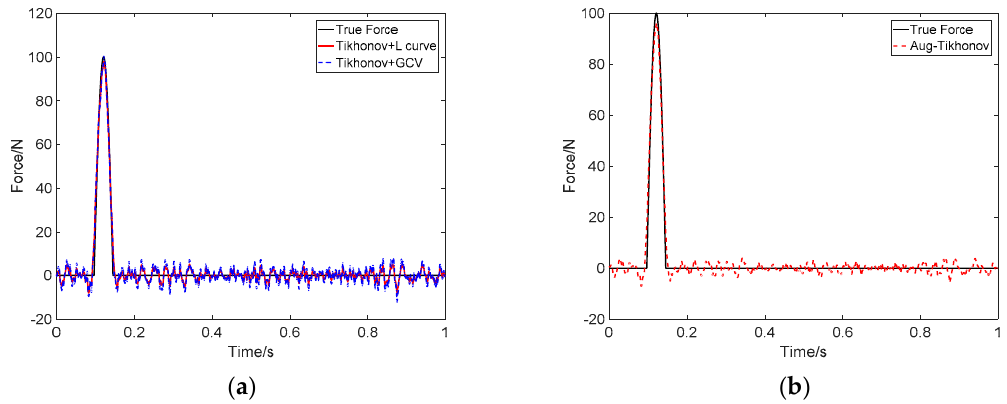
Figure 27. Identification result of impact load at SNR 30 dB on cantilever: ( a ) Tikhonov method; ( b ) the proposed method. Table 4. Force identification e ff ect of